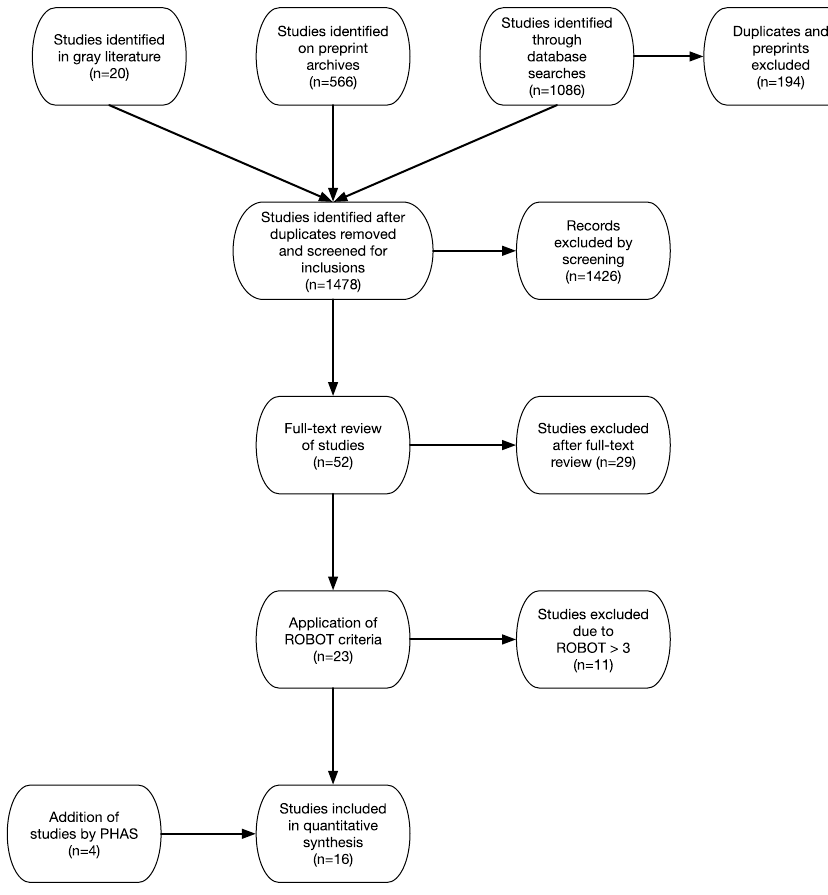
Figure 1. PRISMA flow-chart indicating the number of studies identified, screened, and confirmed for eligibility into this systematic